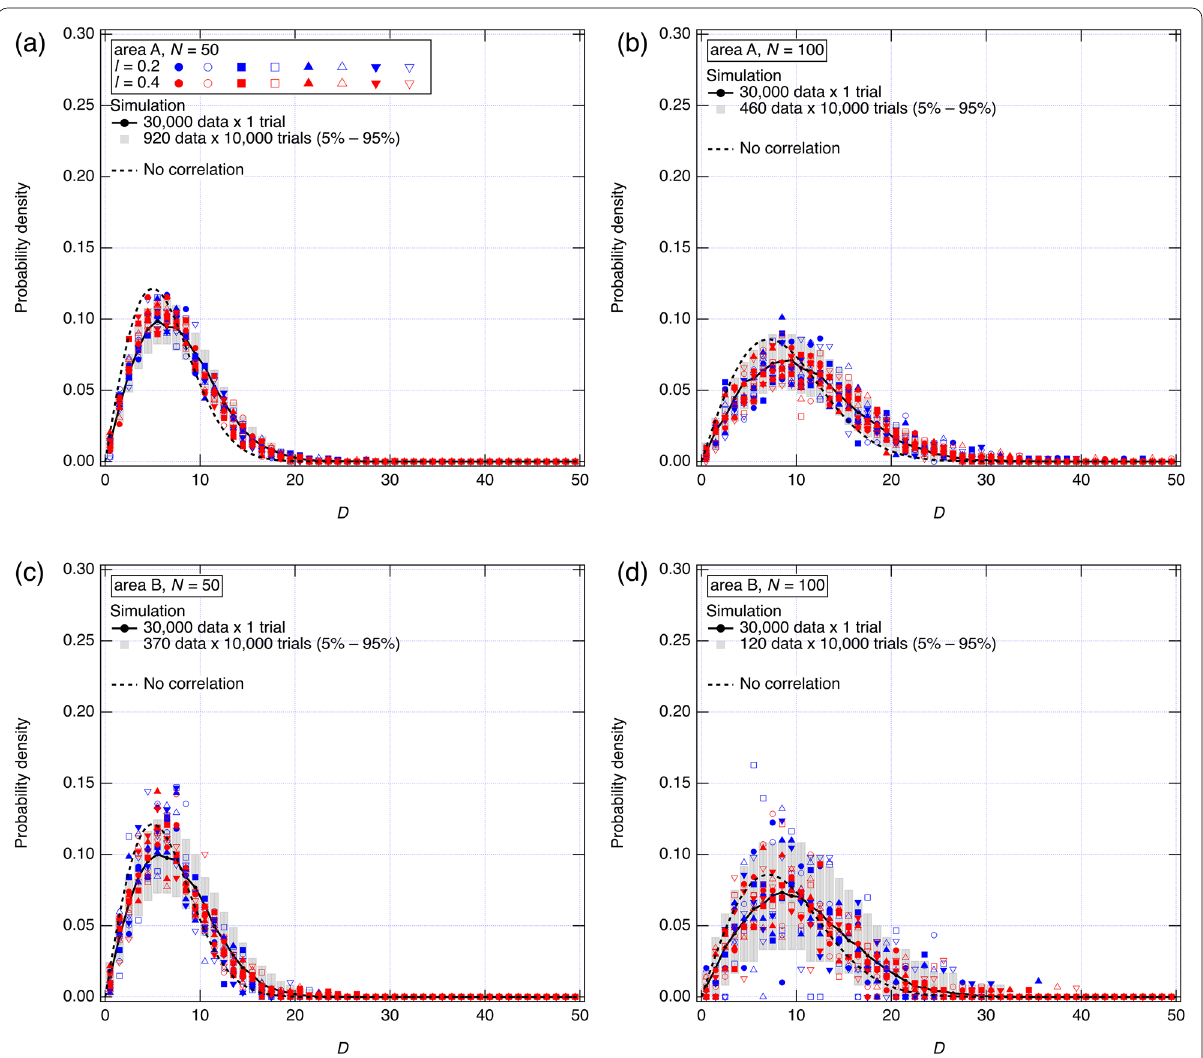
50 in area A; b N 100 in = =